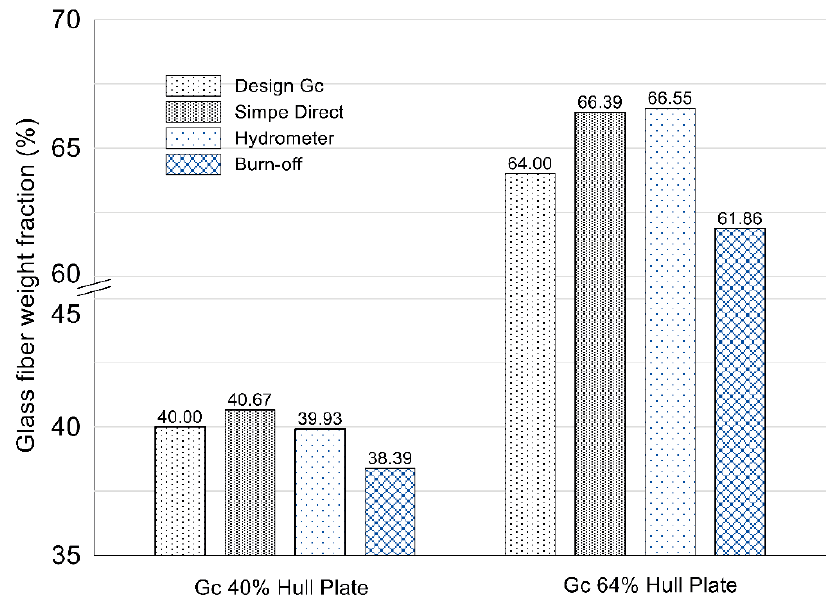
Figure 15. Comparison of Gc values measured by the rule calculation, direct measurement, and burn- off methods.